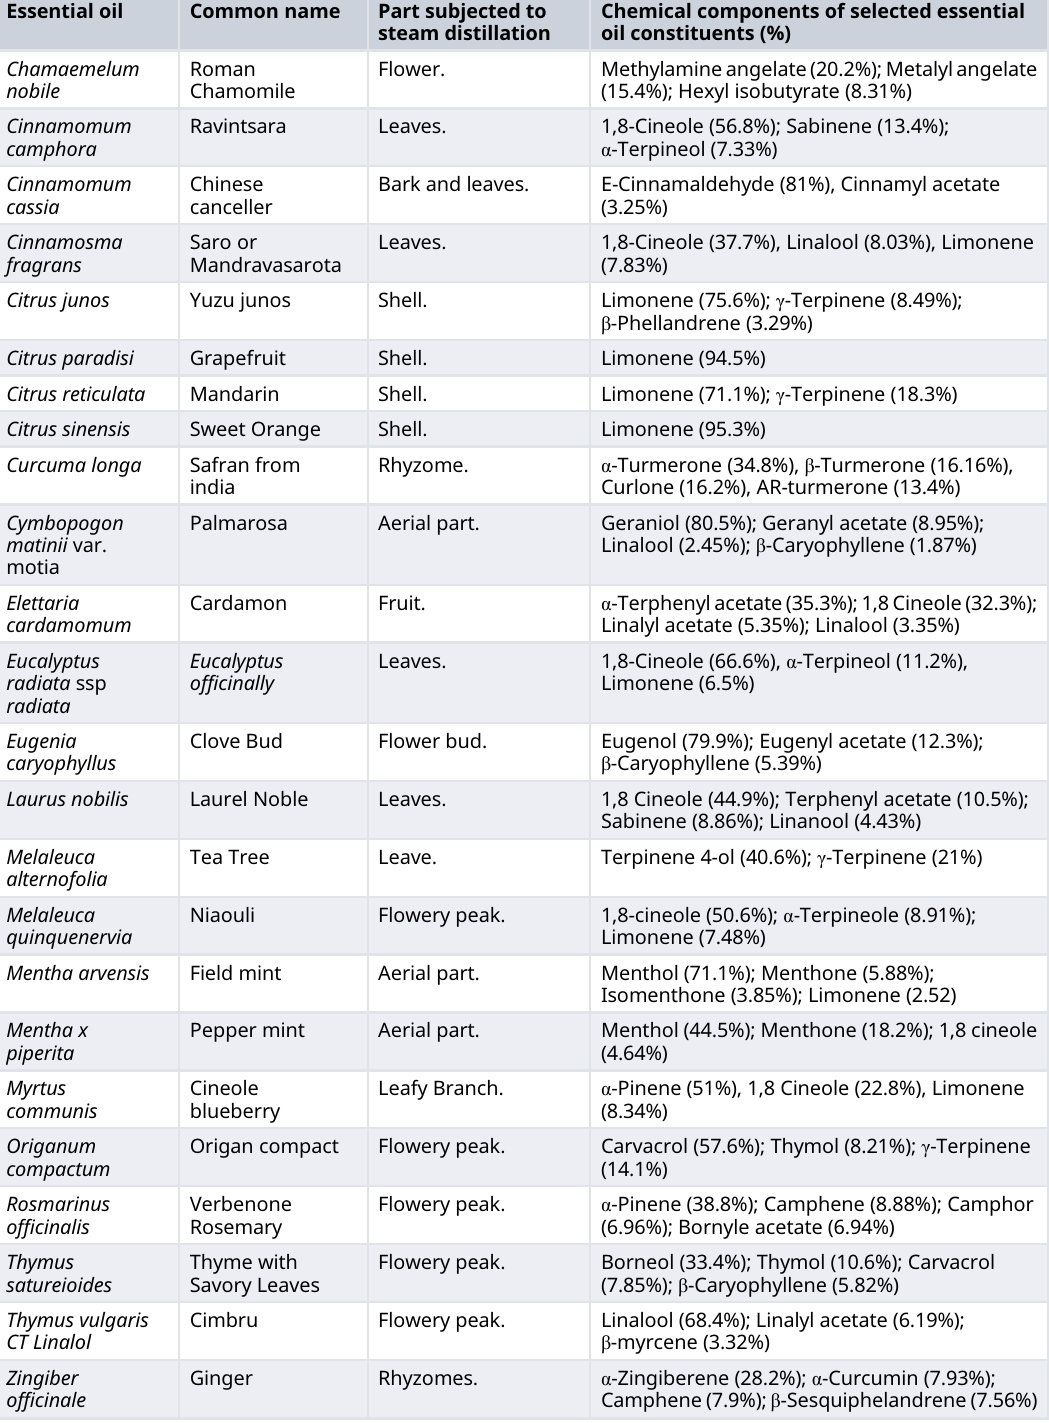
Table 1. Chemical components from the essential oils. The table shows the essential oils analyzed: common name, part of the plant and a percentage of some chemical components of selected essential oil after being subjected to steam distillation (data obtained from analysis sheet of Pranarôm; https://pranarom.us/products/